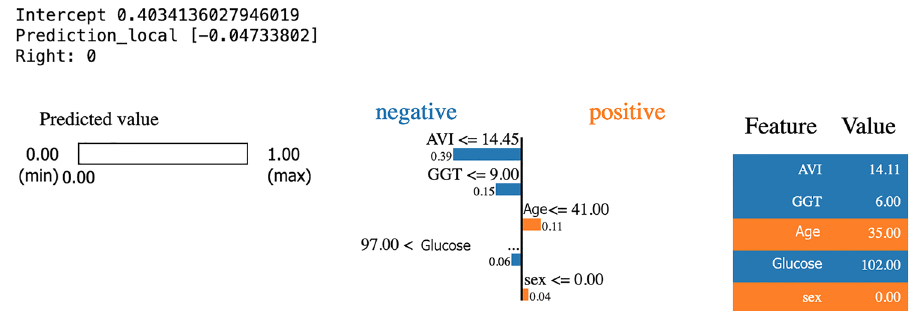
Figure 10. Application of LIME for diagnosis of healthy subject during the test.